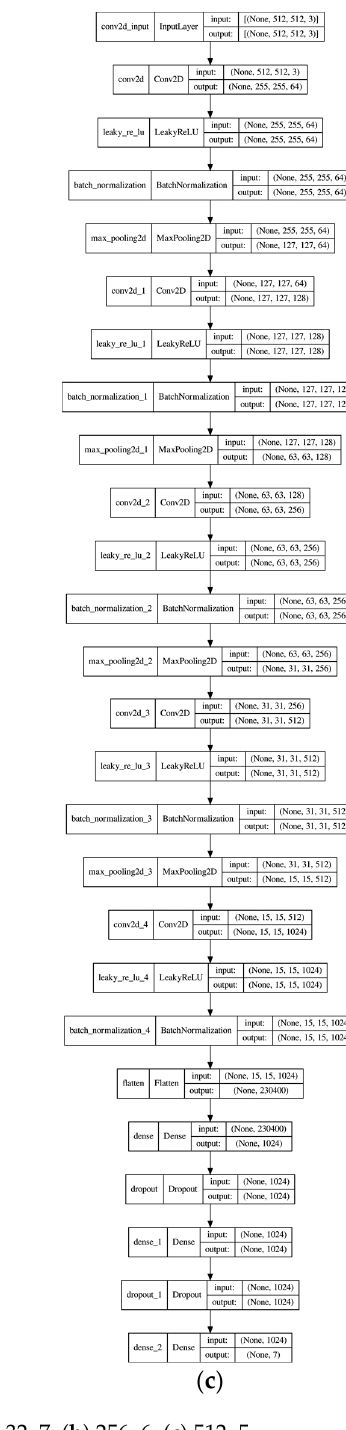
Figure 7. FlexibleNet with different scales and depths: ( a ) 32, 7; ( b ) 256, 6; ( c ) 512, 5 .